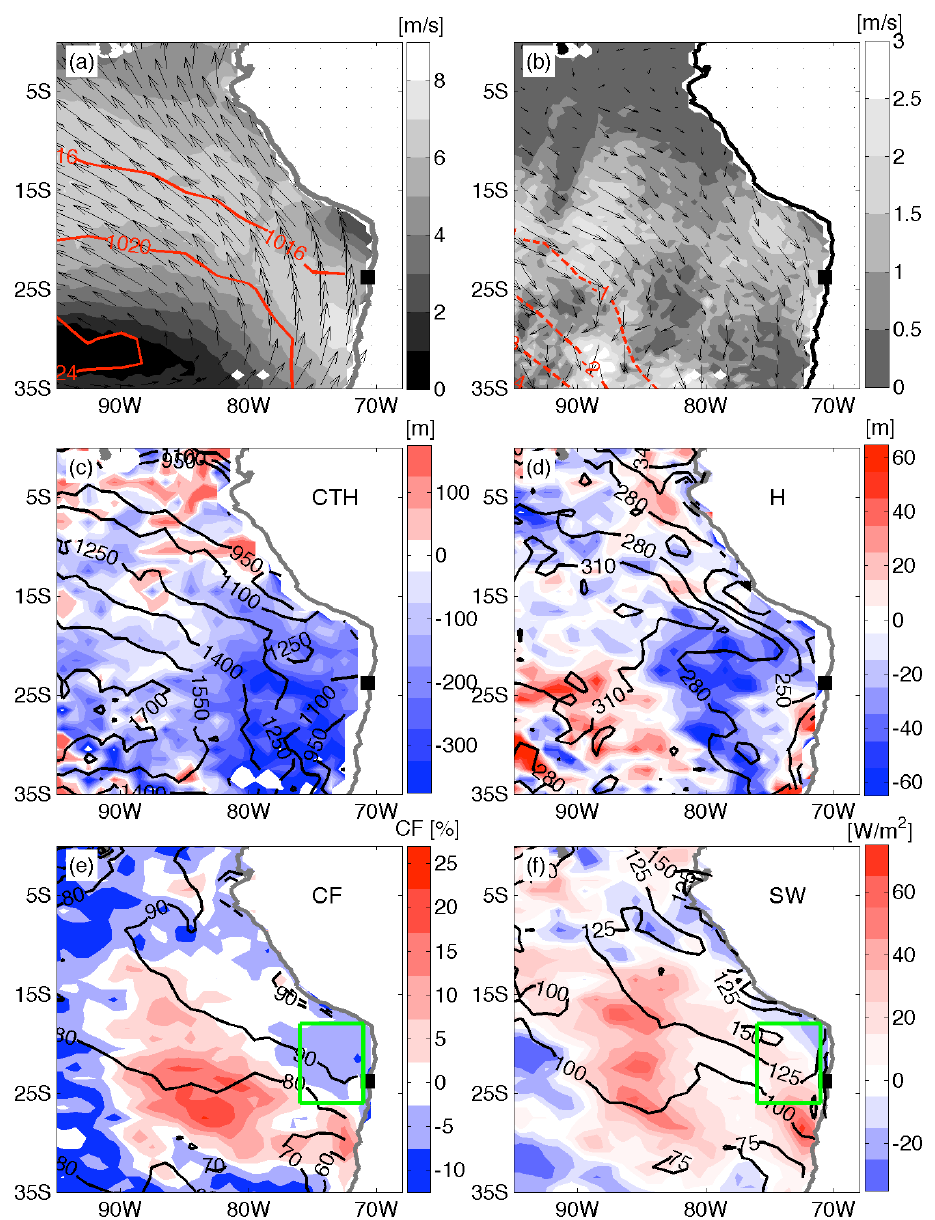
Fig. 5. (a) Mean and (b) MAX-MIN N d composite NCEP sea level pressure (red contours), surface wind magnitude and direction (greyscale Figure 5. a) Mean and b) MAX - MIN N composite NCEP sea level pressure (red d and arrows; QuikScat descending pass, 18:00LT). Mean (contours) and MAX-MIN composite difference (colors) in (c) MODIS-derived contours), surface wind magnitude and direction (greyscale and arrows; QuikScat cloud top height, (d) MODIS-derived cloud depth, (e) MODIS cloud fraction and (f) CERES top-of-atmosphere shortwave fluxes. All MODIS data is Terra daytime level 3. Location of Antofagasta indicated by black square, and Arica Bight domain is shown in Fig. 6e and descending pass, 18LT). Mean (contours) and MAX-MIN composite difference (colors) in c) MODIS-derived cloud top height, d) MODIS-derived cloud depth, e) MODIS cloud